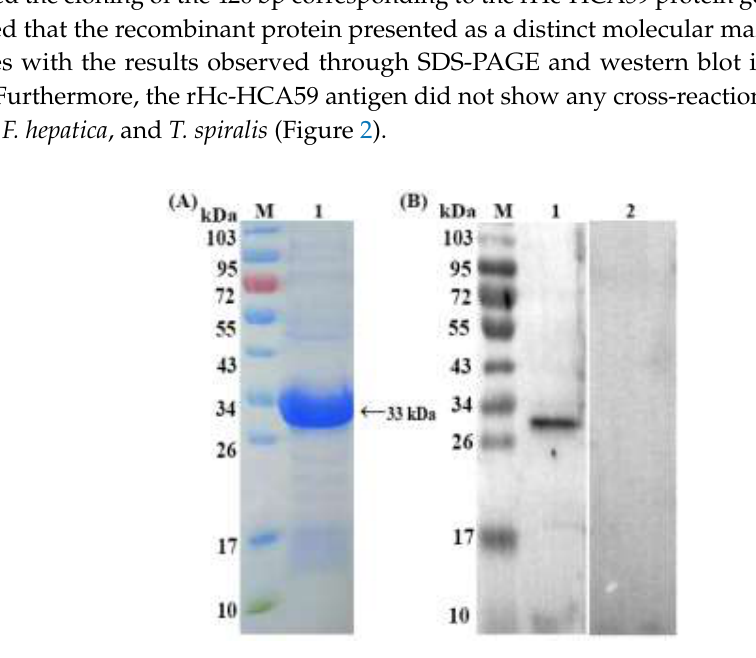
Figure 1. Purification and western blotting of rHc-HCA59 protein. Lane M: standard protein pre stain molecular weight marker. ( A ) Lane 1: Purified rHc-HCA59 protein. ( B ) Lane 1: Antibodies were detected by infected goat sera; Lane 2: membrane incubated with normal goat sera (as control).